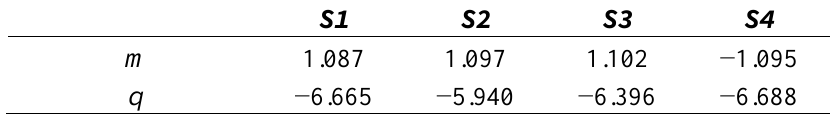
Table 4. Models for re-calibration of